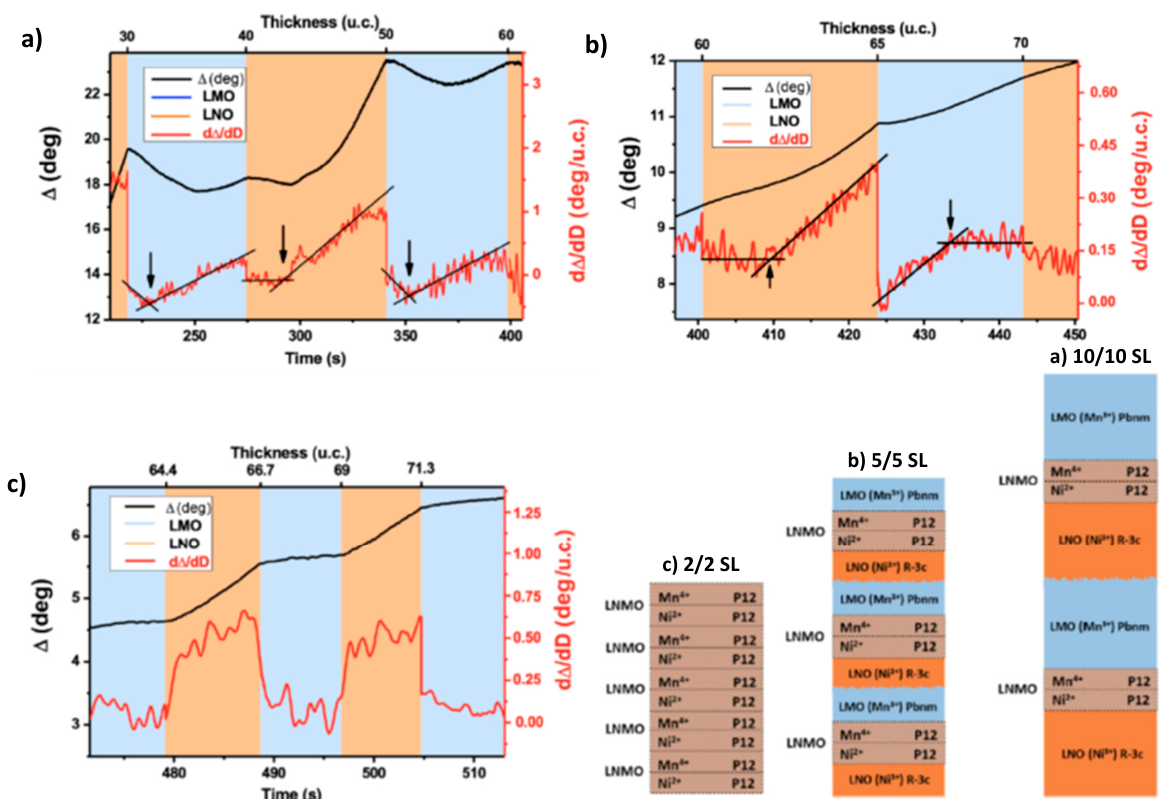
Figure 7. Ellipsometry diagrams of ( a ) 10/10, ( b ) 5/5, and ( c ) 2/2 SLs and the model of electronic/structural phase distribution in these SLs. Adopted with permission from American Physical Society (Copyright 2021) ref. [9].